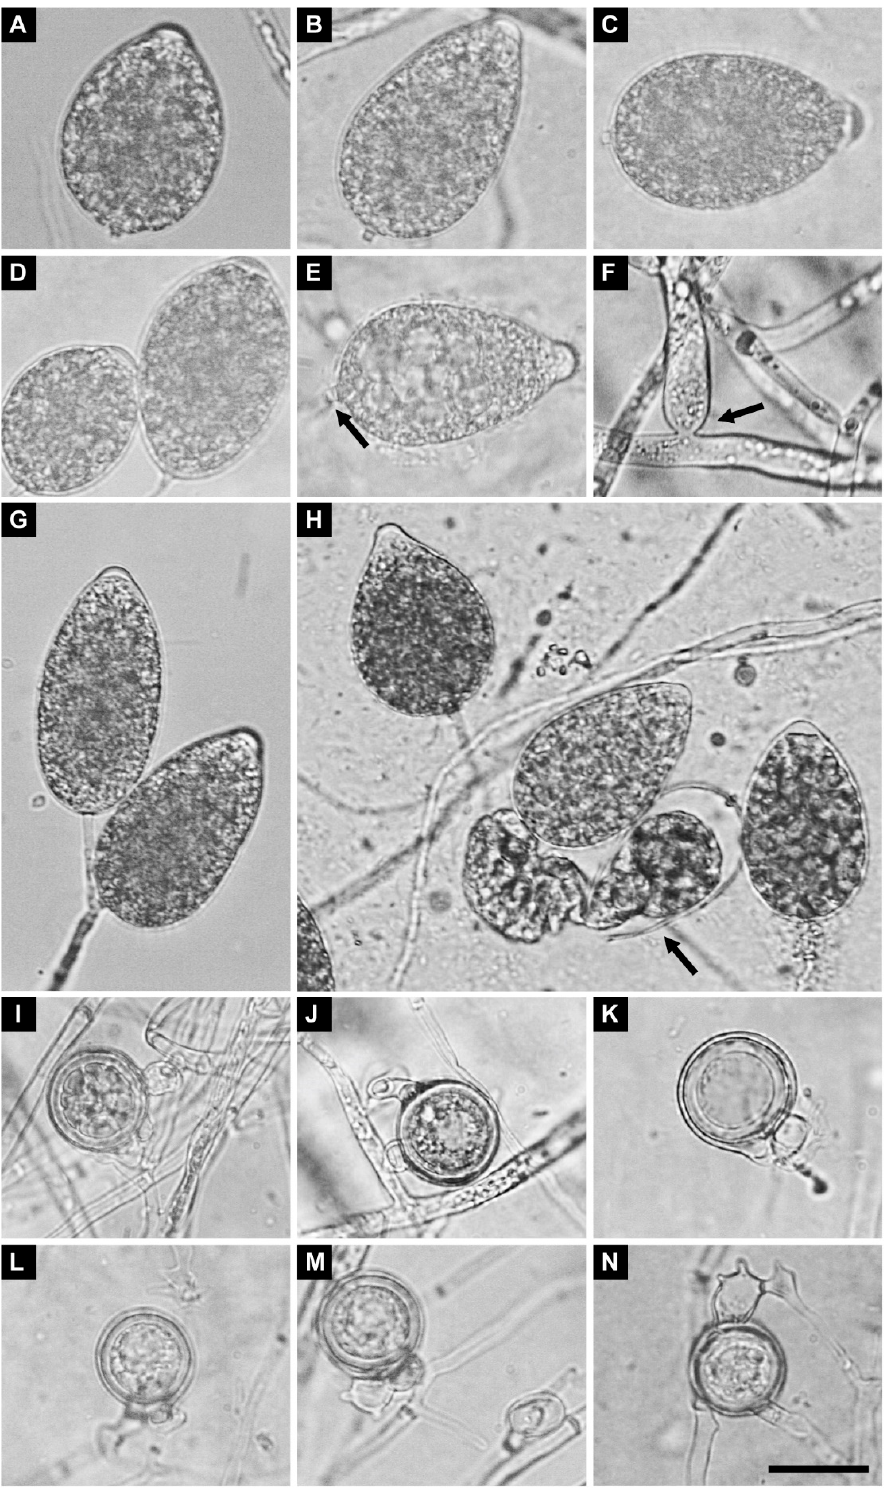
Figure 4. Sporangia and oospores of Phytophthora podocarpi . ( A – H ). sporangia and hyphal constriction, ( A – C ). semi papillate, caducous, ovoid sporangia, ( D ). non-papillate, limoniform sporangia, ( E ). semi-attached sporangia (indicated by arrow) with zoospores clearly visible, ( F ). distinct swelling of hyphae after constriction at point of branching (arrow), ( G ). simple sympodial sporangiophores, ( H ). caducous sporangia releasing zoospores (arrow), ( I – N ). gametangia, ( I – L ). oogonia with paragynous antheridia, ( M , N ). oogonial stalk with digitate projections. Scale bar = 25 μ m.